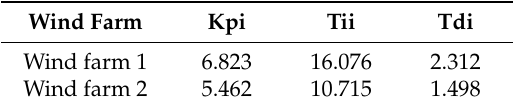
Table 1. The optimal results of DFIG damping control in WSCC system.